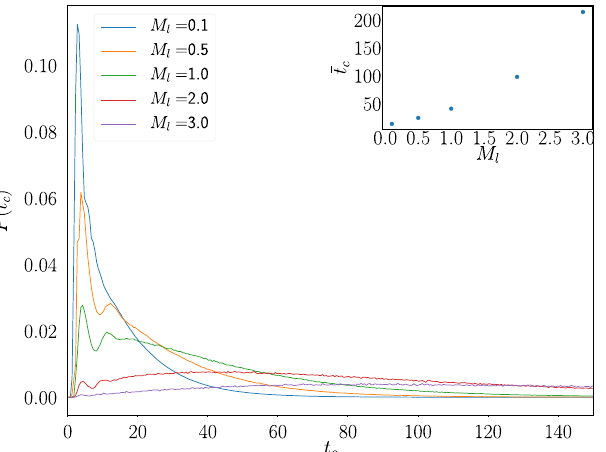
Figure 5. Cycle duration t c pdf for systems with p = 0.2 and several values of M l . The inset shows the average cycle duration time ¯ t c as a function of M l .